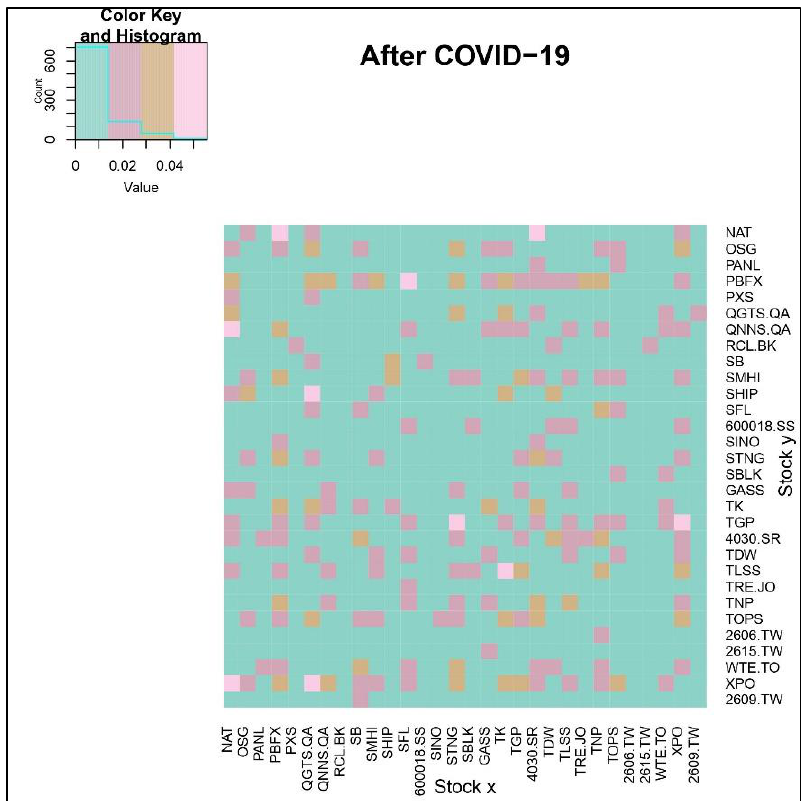
Figure 4. The information flow (effective transfer entropy) from stock y to stock x, for the companies 41 through 70 (listed in Table 1), after the COVID-19 outbreak